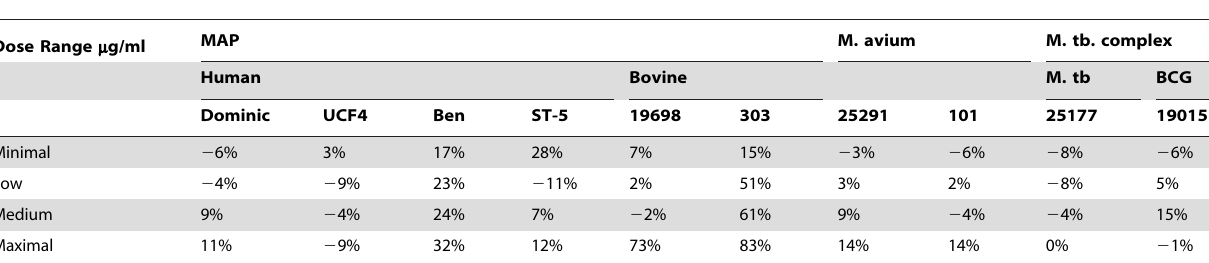
Table 2. Negative Control: Phthalimide.